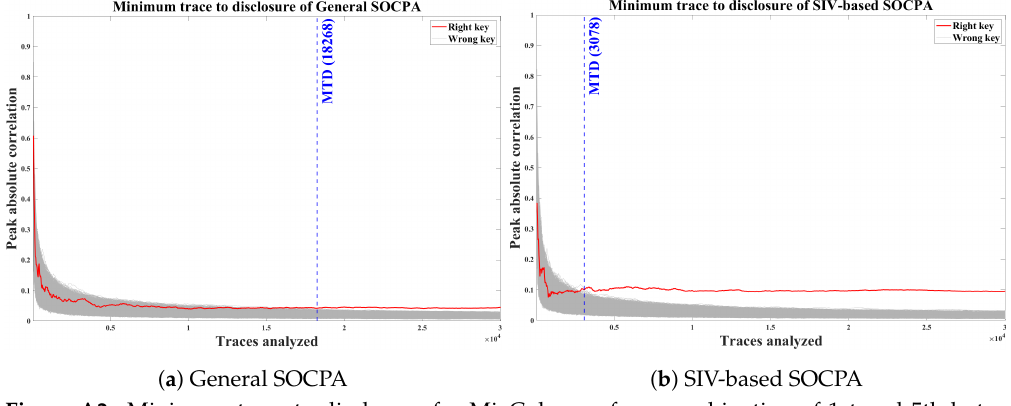
Figure A2. Minimum trace to disclosure for MixColumns for a combination of 1st and 5th bytes (Absolute-Difference).